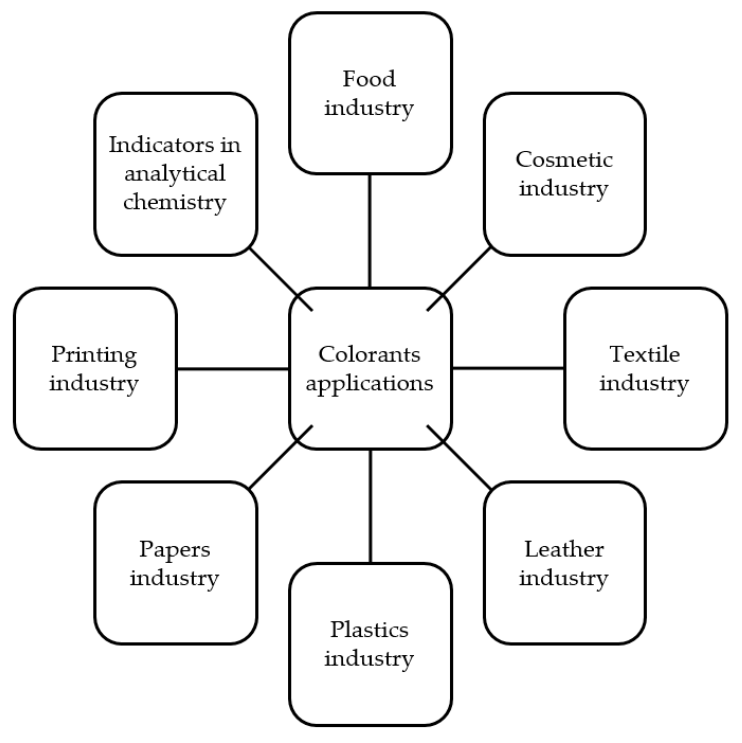
Figure 1. The exemplary industrial application of colorants.